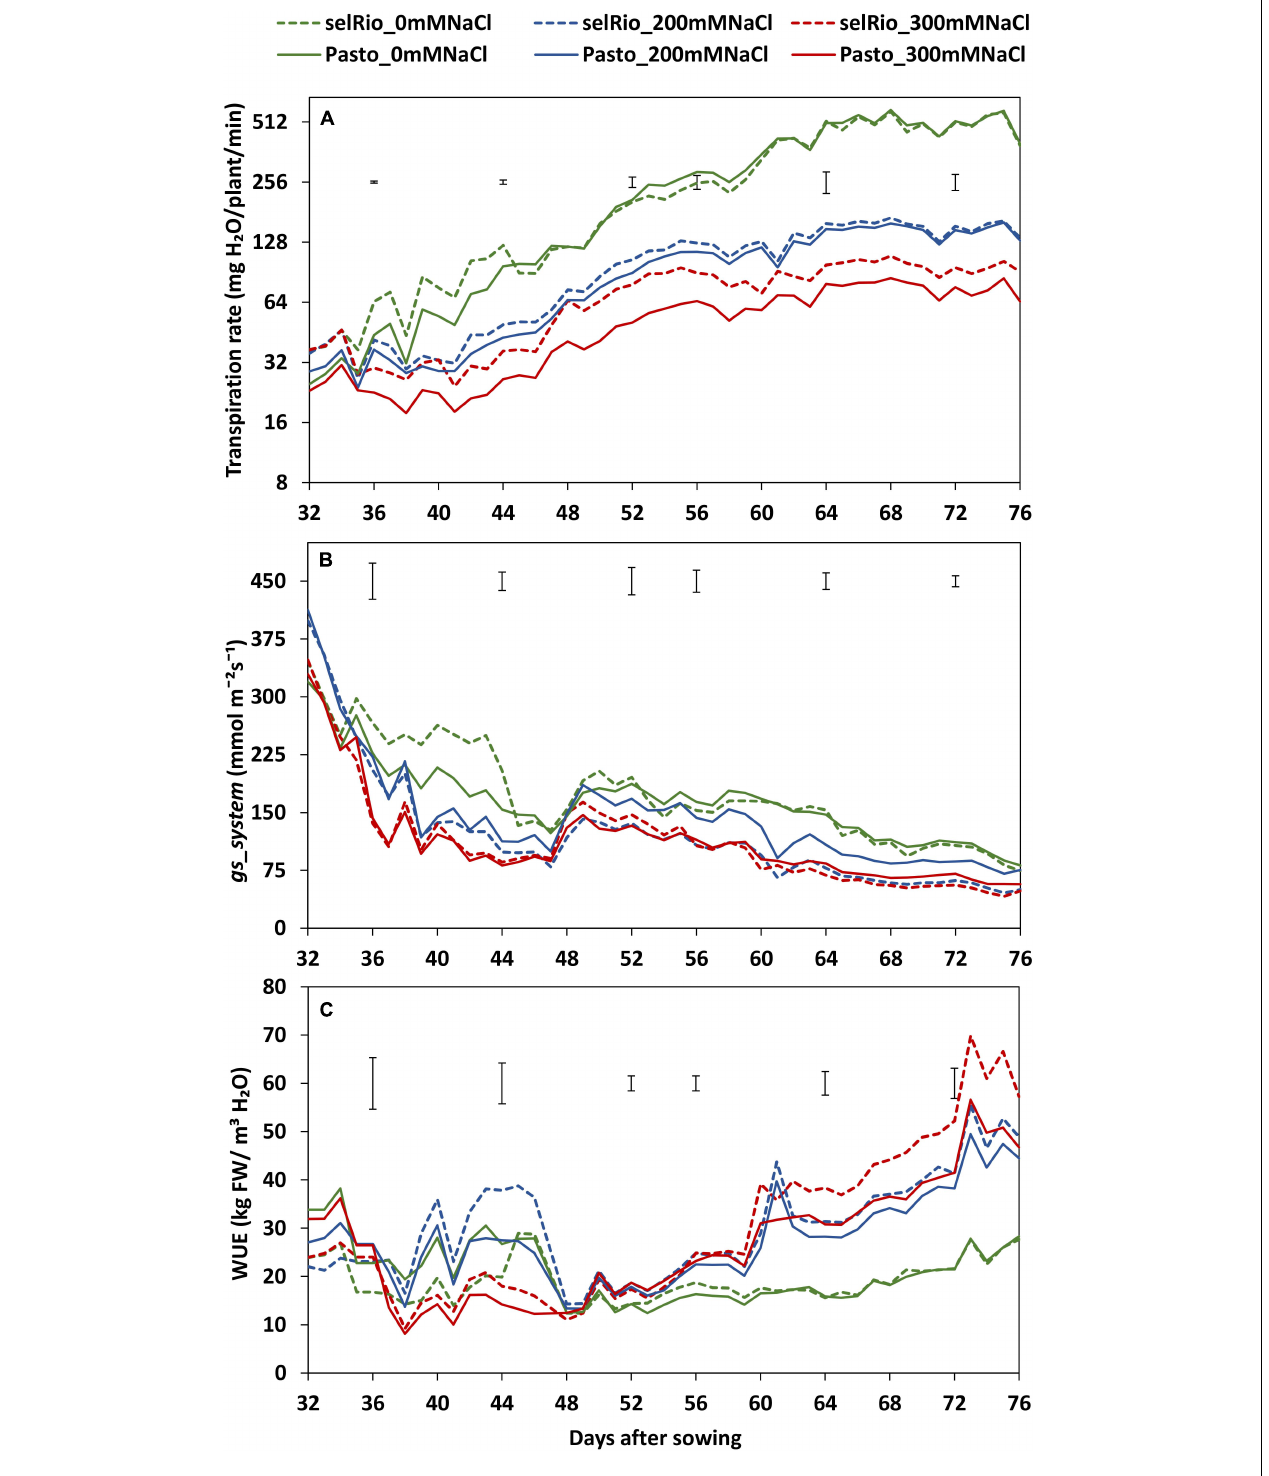
FIGURE 3 | Water use parameters derived from Plantarray 3.0 data. (A) Average transpiration rate per day considering the hours of light received by the plants in the greenhouse. (B) Average stomatal conductance ( gs_system ) per day considering the hours of light received by the plants in the greenhouse. (C) Average whole-plant agronomic water use efficiency (WUE) per day considering the hours of light received by the plants in the greenhouse. Means of 4 plants. Error bars indicate the SEM (standard error of mean) from the ANOVA at a specific timepoint.